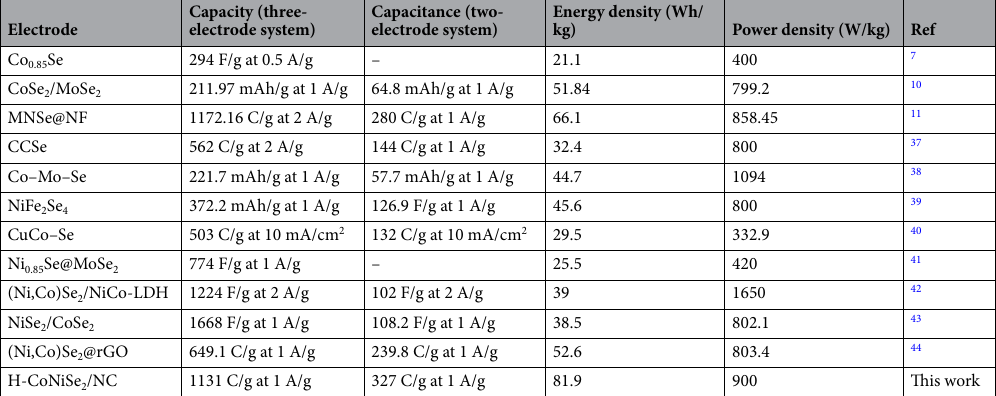
Table 1. Comparison of the proposed electrode with some transition metal selenide electrodes.